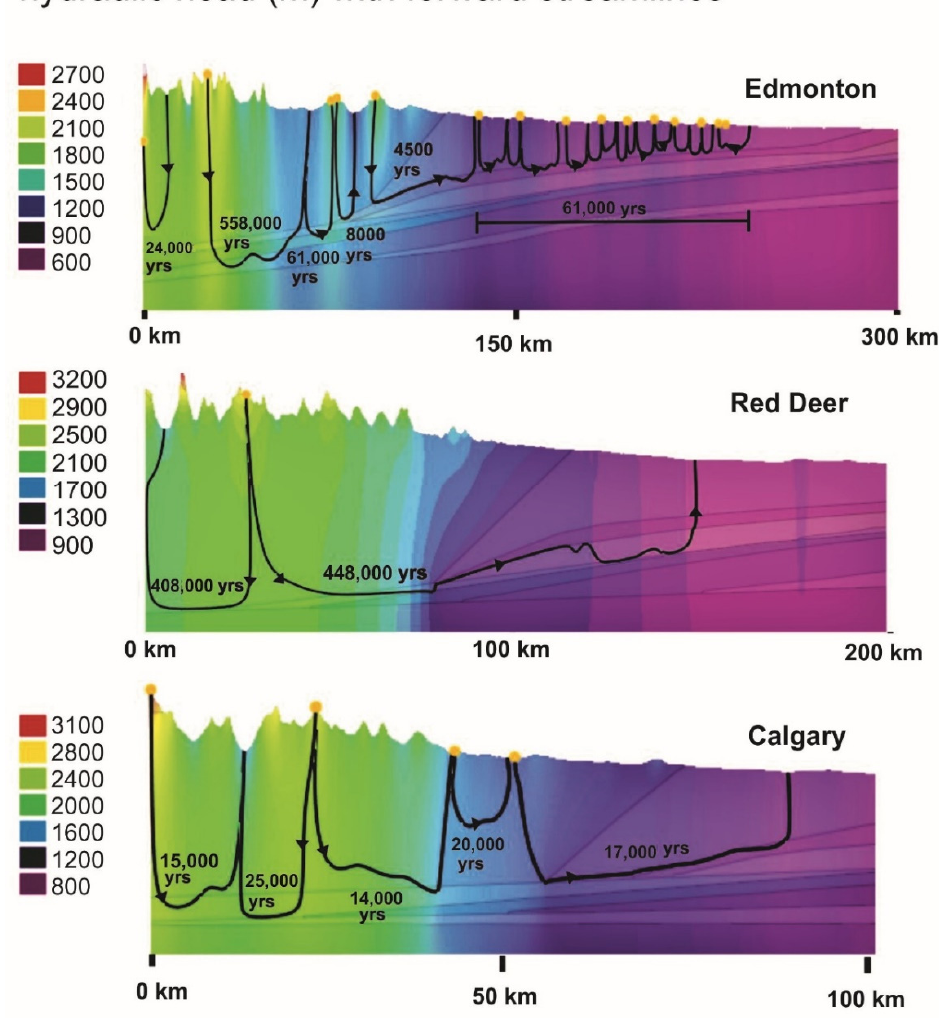
Figure 12. Hydraulic head and flow paths distribution for the three cross sections. Groundwater flow rates driven essentially by differences in elevation are shown with ranges from 0.25 to 8 m/y for the three models in deep aquifers (Paskapoo, Lea Park, and Cretaceous). These flow rates indicated with flow paths in Figure 13 are similar to the typical values in deep aquifers with similar conditions as reported by Garven and Freeze,